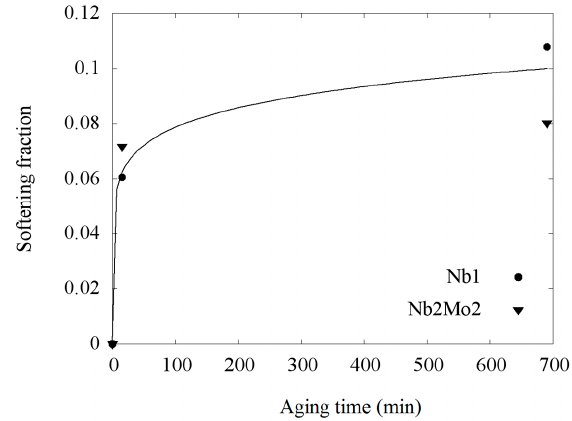
Figure 12. Softening fraction due to tempering of the bulk microstructure during aging at 630 °C for Nb1 and Nb2Mo2 steels, calculated using Equations (4)–(8) with the EBSD data. Solid line depicts the proposed tempering model according to Equation (9).